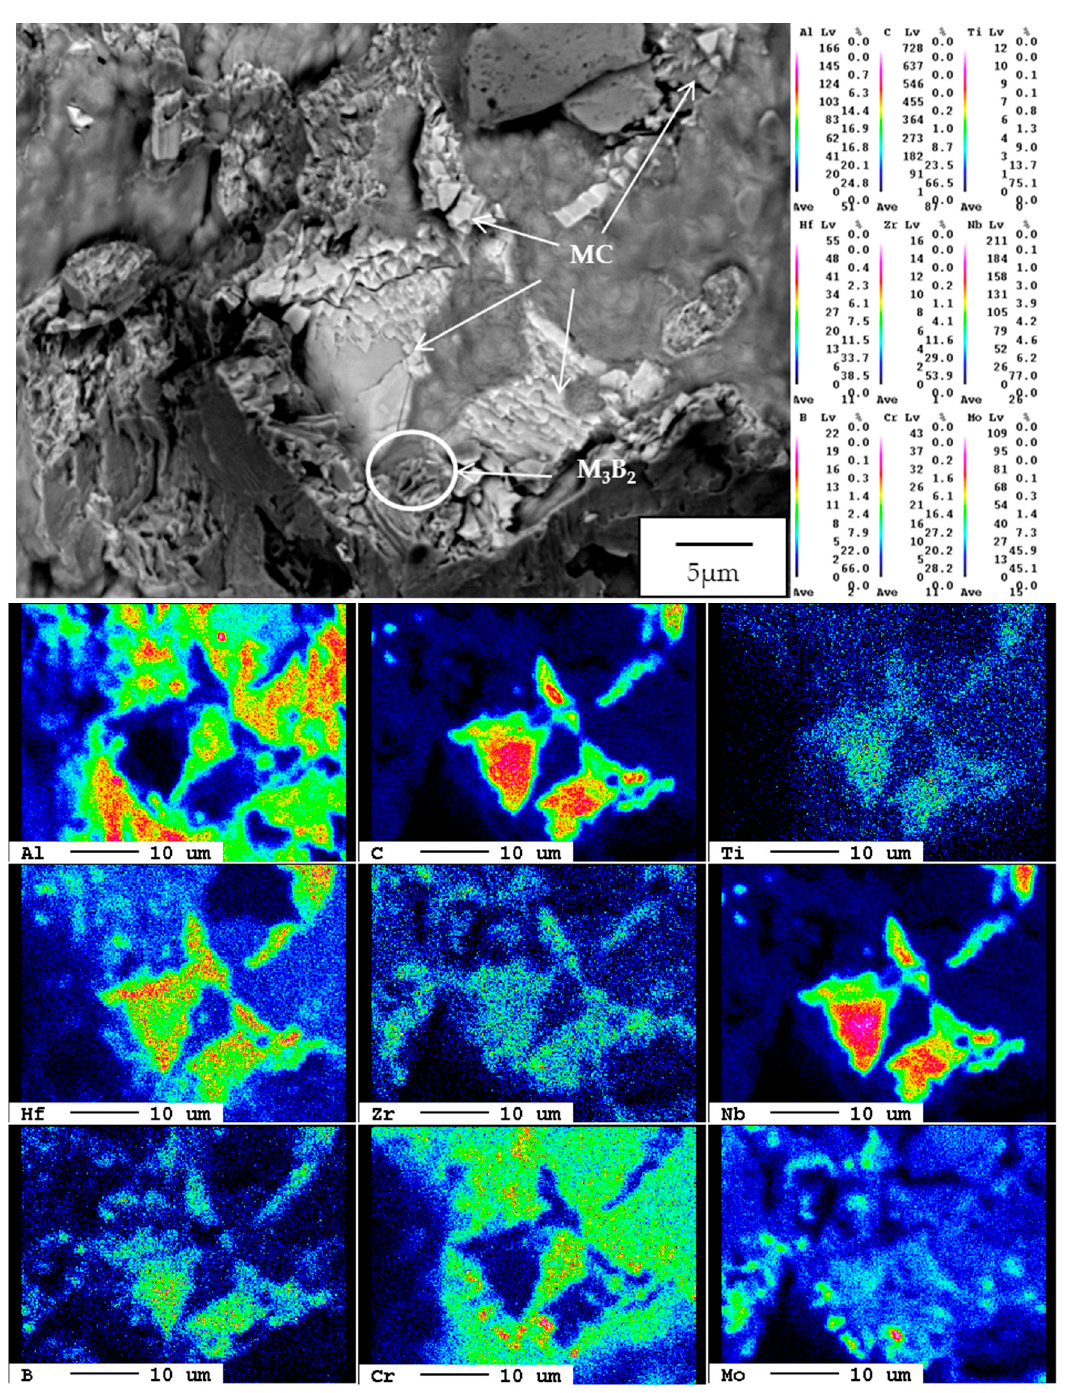
Figure 9. SEM fractograph of liquation crack and the associated EPMA maps of the Al, C, Ti, Hf, Zr, Nb, B, Cr, Mo elements on the fracture surface.